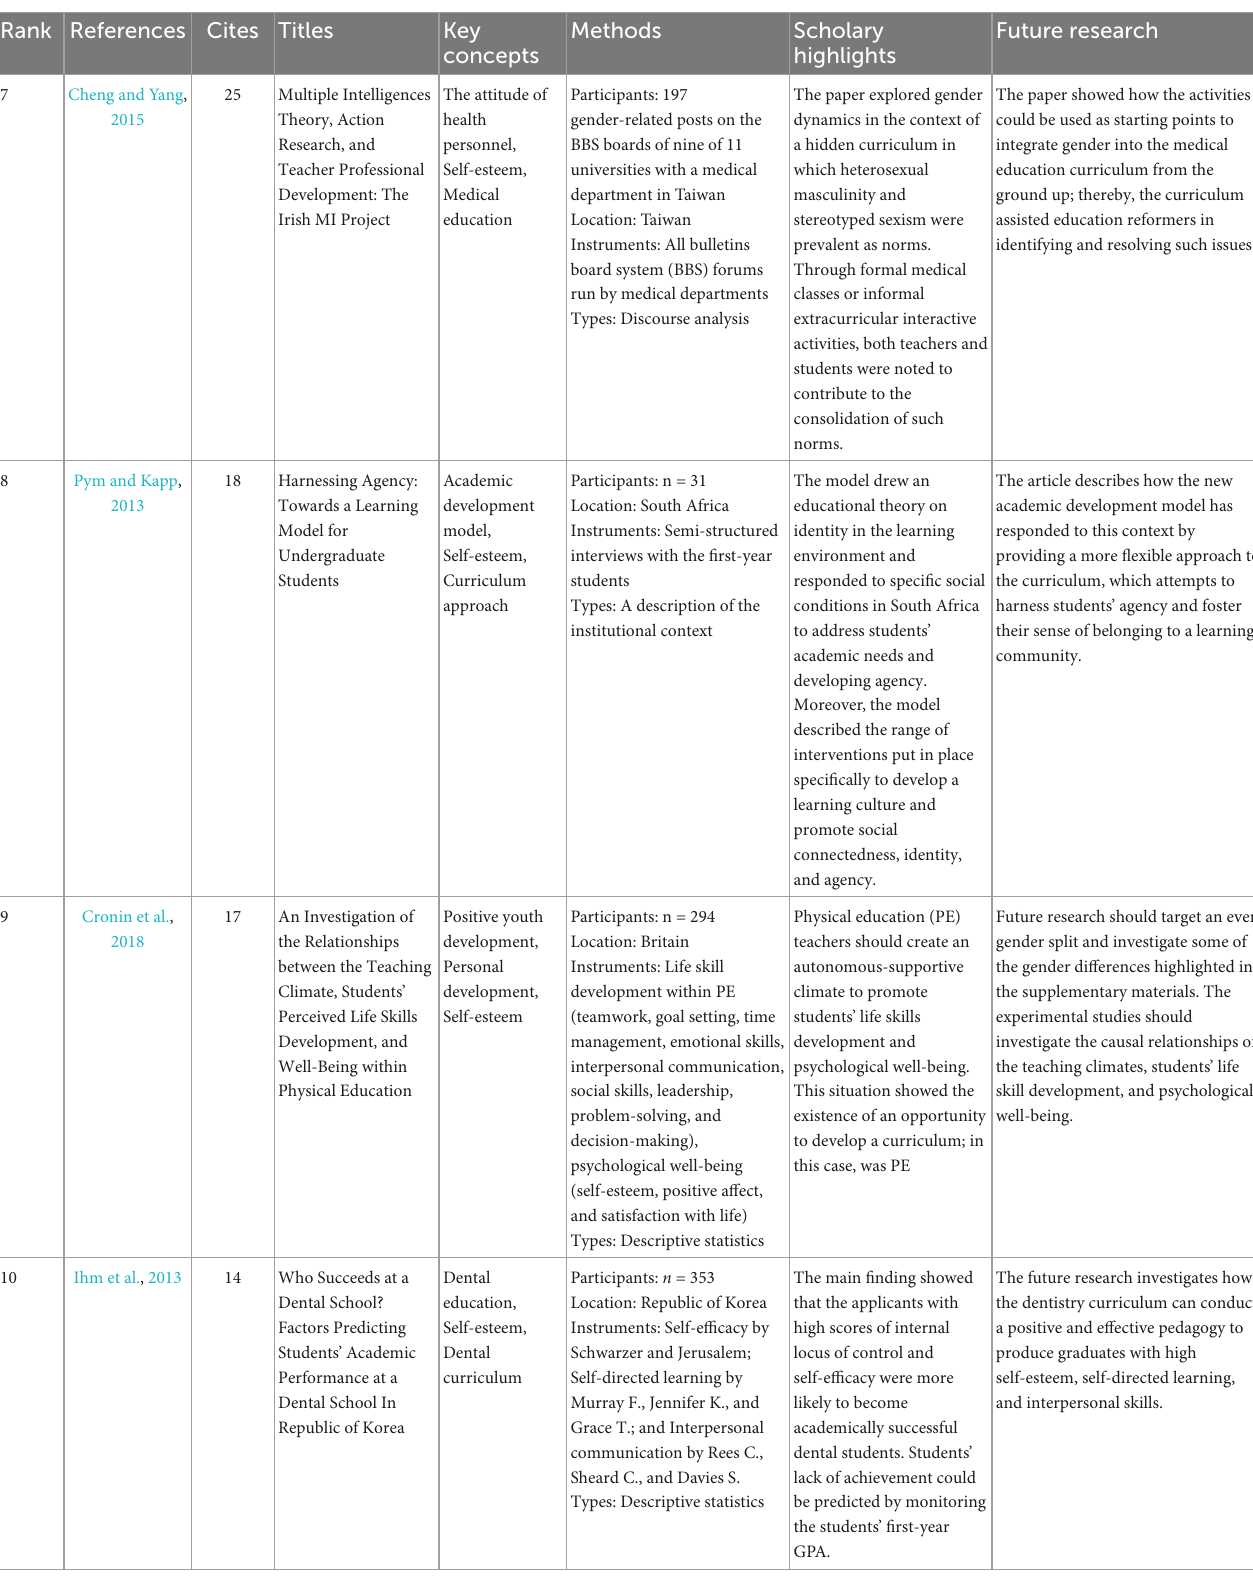
Figure 5 signifies that the number of documents is not always associated with many citations due to many factors.